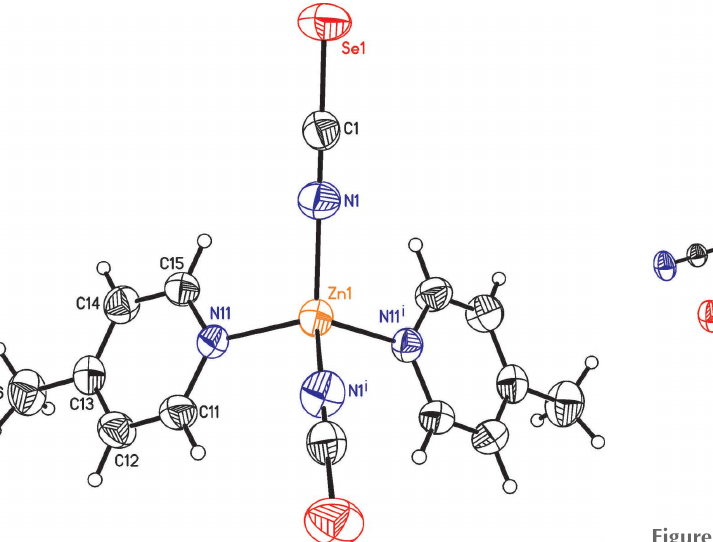
Figure 1 The molecular structure of 1 with displacement ellipsoids drawn at the 50% probability level. Symmetry code: (i) (cid:2) x , (cid:2) y + 1, z .